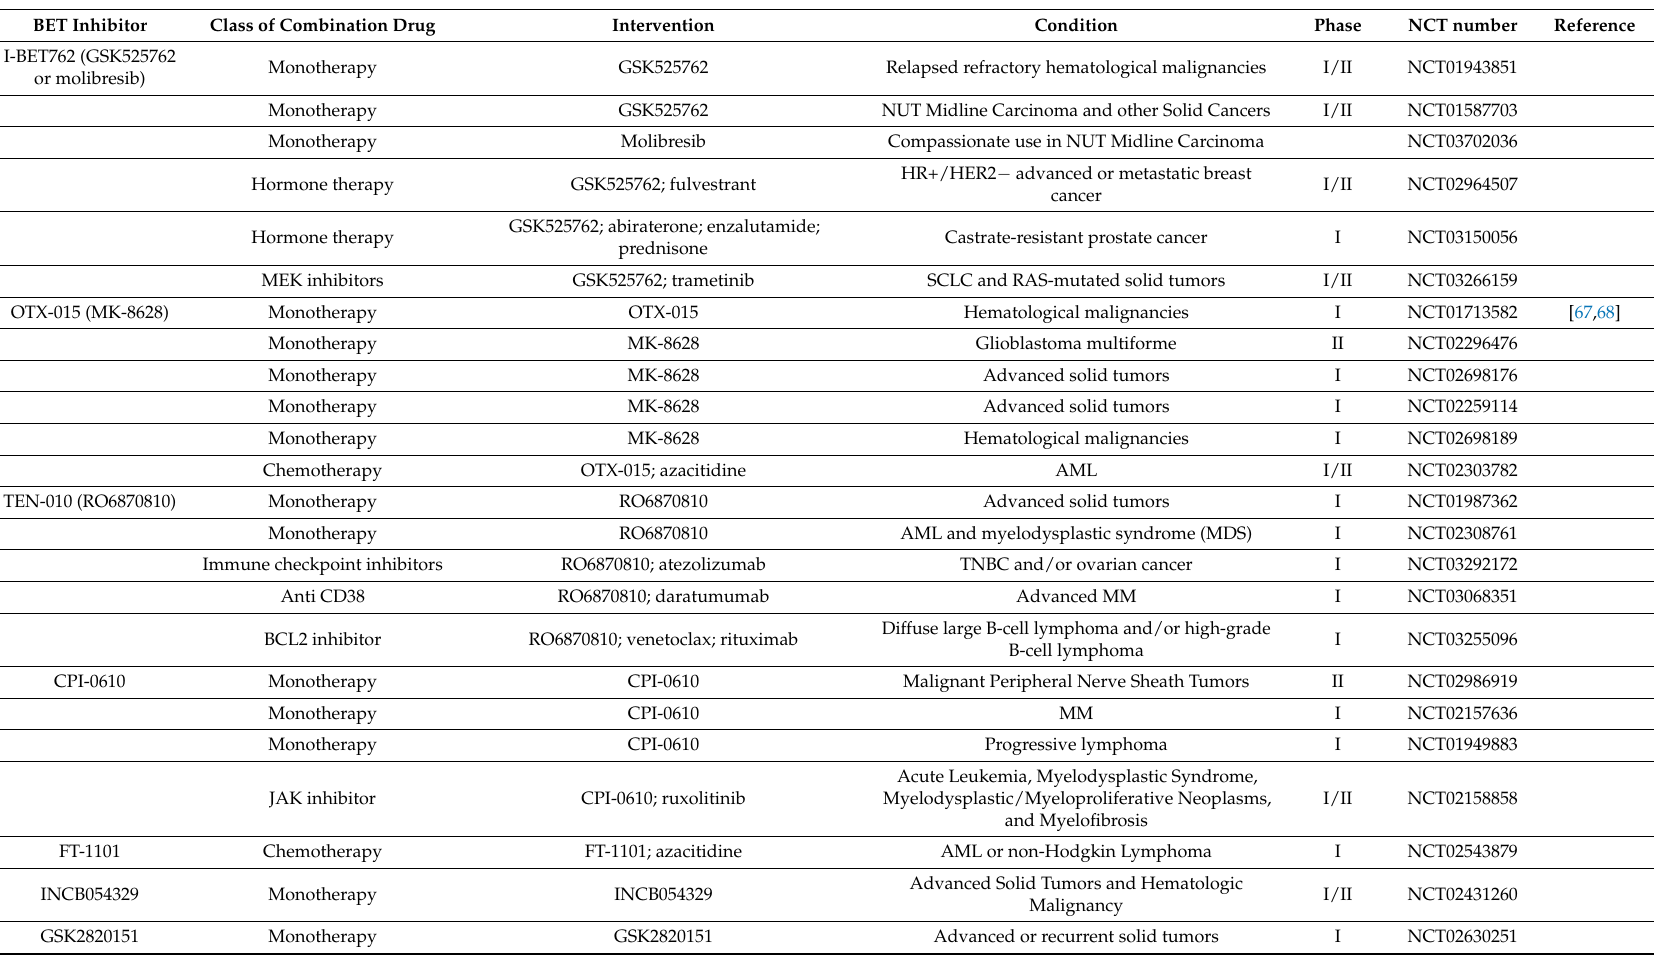
Table 2. Summary of published and ongoing clinical trials evaluating BETi as monotherapy or in combination with other anti-cancer